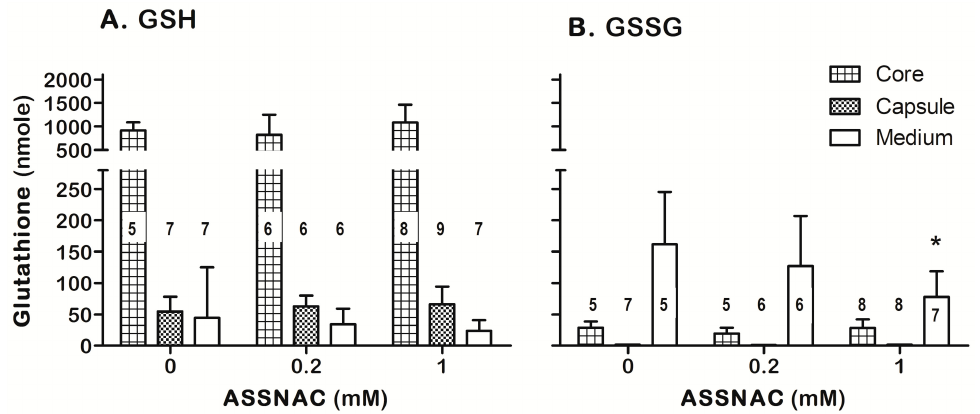
Figure 8. E ff ect of ASSNAC on GSH and GSSG content in lens core, capsule and incubation medium. Lenses were cultured without (0; control) or with ASSNAC (0.2 mM or 1 mM) for 1 day. Media were harvested and lens core and capsule were separated. The level of GSH ( A ) and GSSG ( B ) were determined. The number of lenses per each treatment is indicated in each bar. Significant di ff erence was marked: * p < 0.05 versus control.